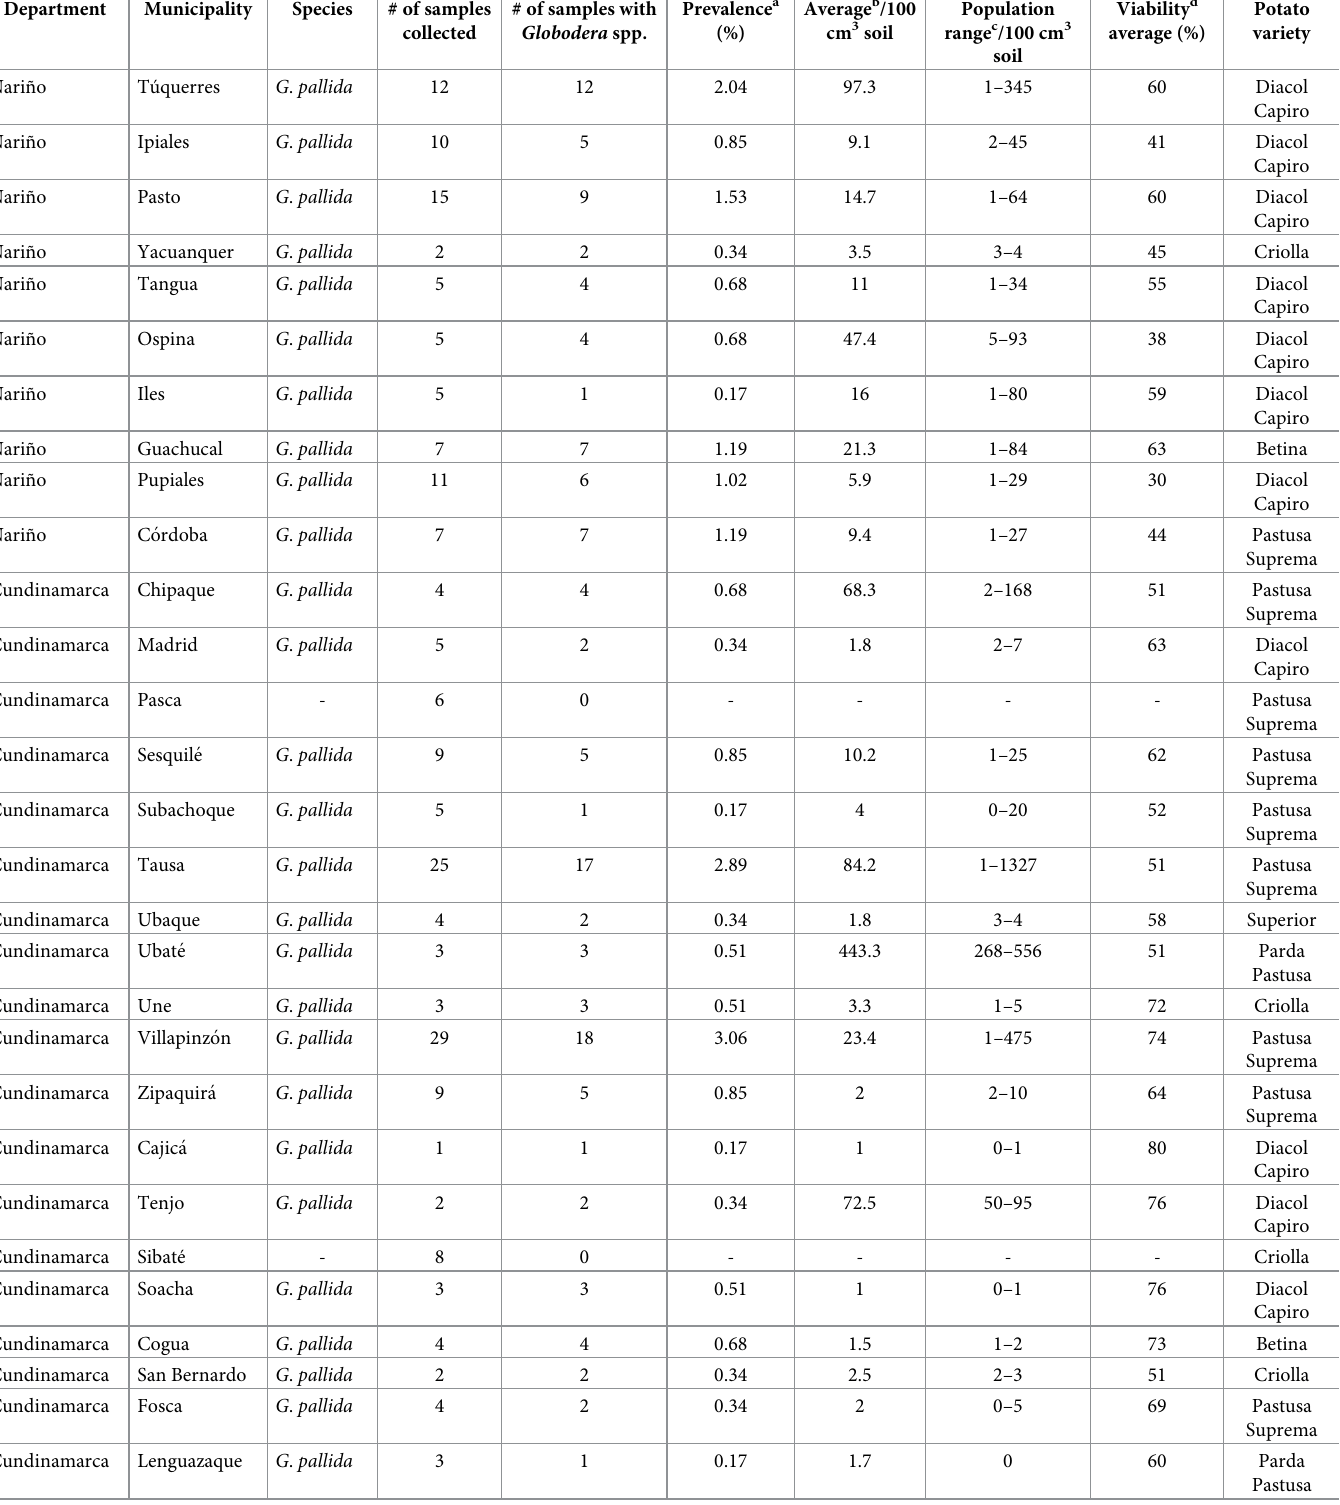
Table 1. Globodera species, density levels, and prevalence (%) in cultivated potato crops from the main growing regions in Colombia.